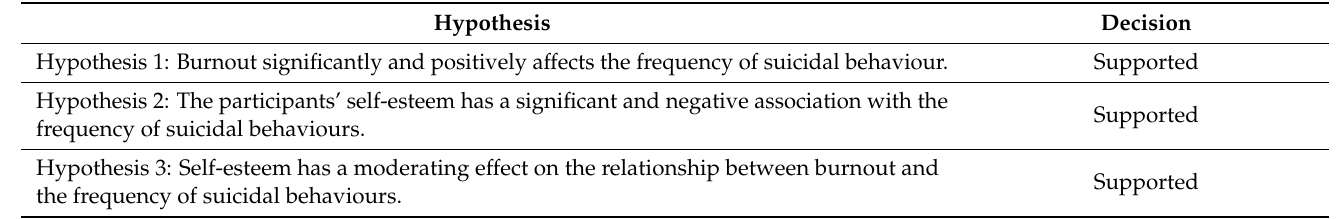
Table 8. Synthesis of the hypotheses